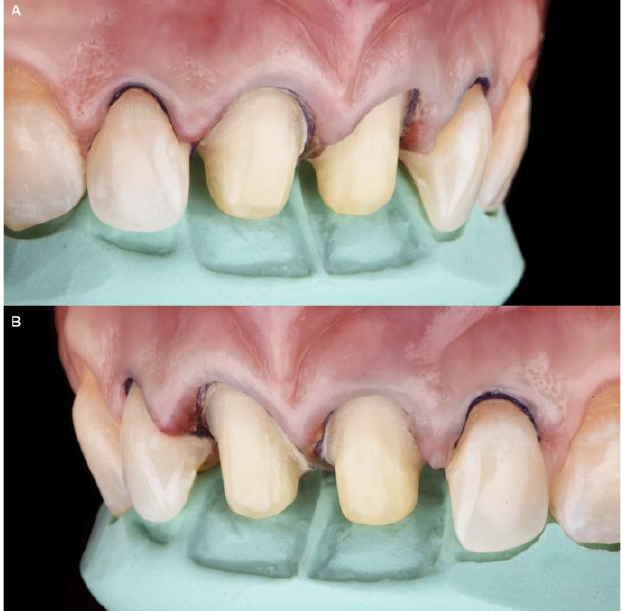
Figure 7. Lateral incisors veneer preparations: ( A ) Right side of the lateral veneer preparation with the reduction guide; ( B ) Left side of the lateral veneer preparation with the reduction guide.